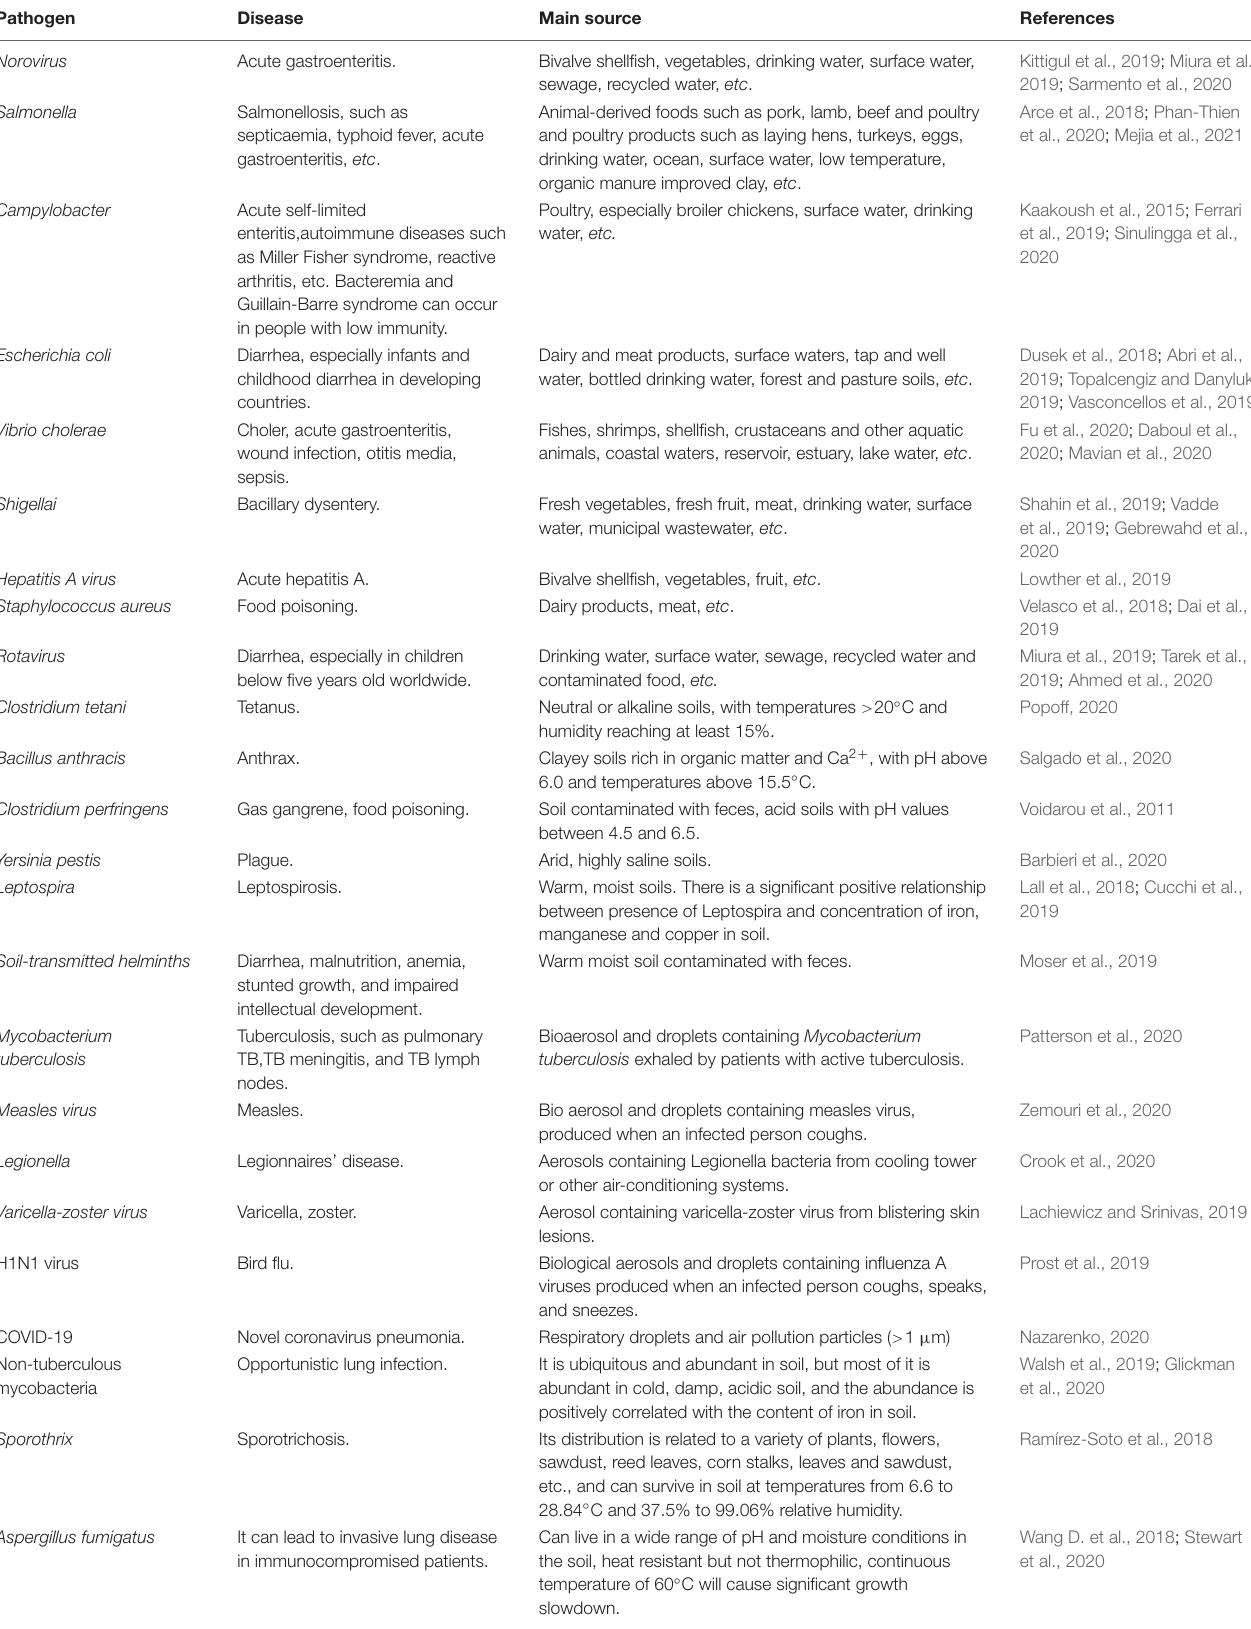
TABLE 1 | Common pathogenic microorganisms in food, environment, related diseases, and main